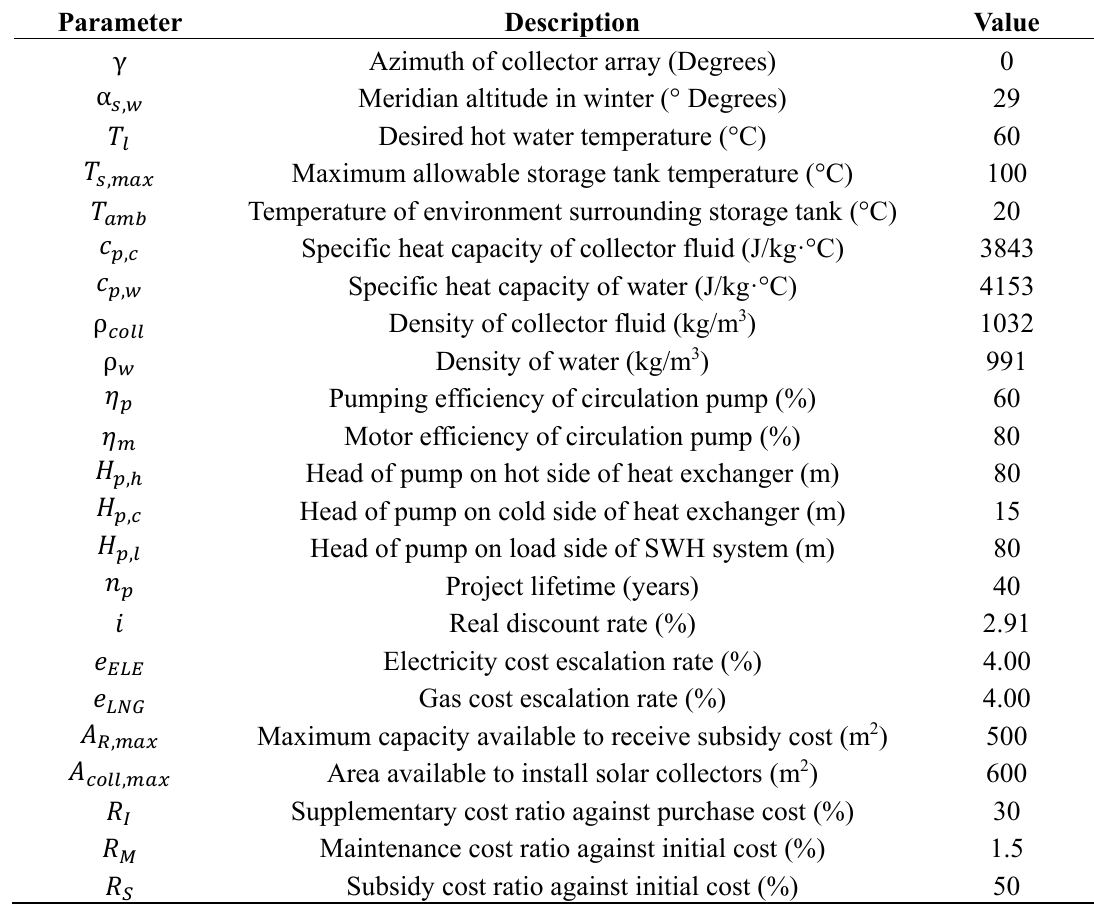
Table 1. Optimization design parameters considered in case study.